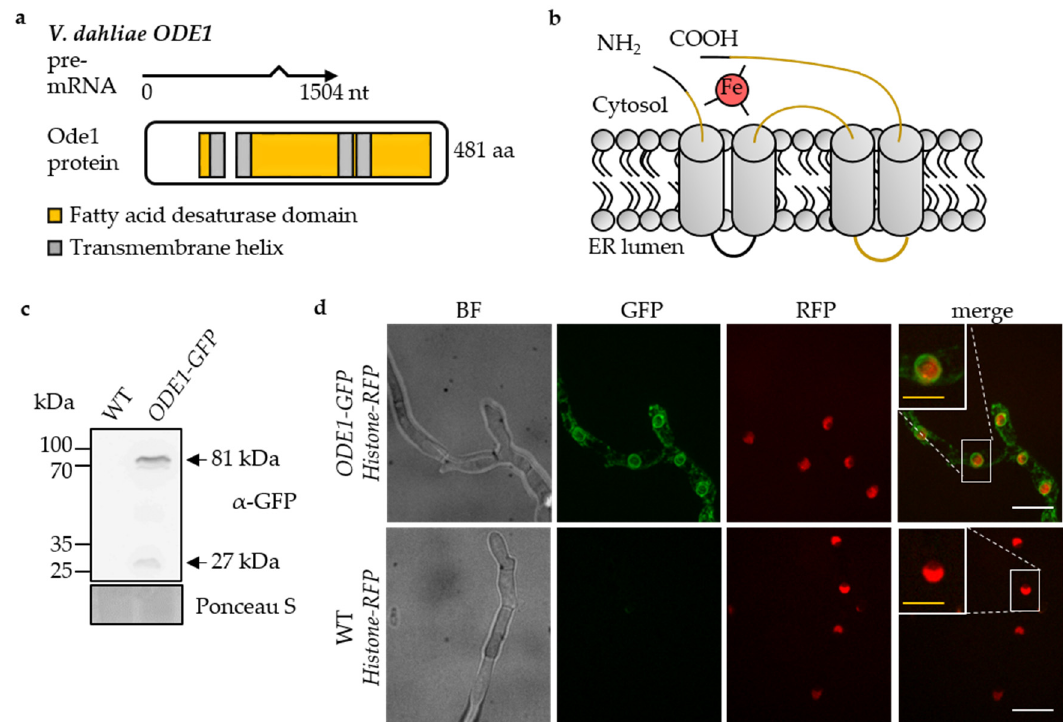
Figure 4. Verticillium dahliae Ode1 is localized to nuclear membranes. The ODE1-GFP strain harbors a functional fusion at the endogenous locus controlled by the native promoter. This strain with or without RFP-tagged histone H2b, and wildtype constitutively expressing RFP-tagged histone H2b (WT Histone-RFP ) were compared. ( a ) V. dahliae oleate ∆ 12-fatty acid desaturase encoding ODE1 intron-exon boundaries (1504 bp) were confirmed by PCR amplification from wildtype cDNA and sequencing. The deduced Ode1 protein (481 aa) contains two fatty acid desaturase domains (FAD; yellow; 77–112 aa, IPR021863; 138–424 aa; IPR005804) and four putative transmembrane helices (grey: 105–124 aa, 136–157 aa, 300–319 aa, 331–350 aa; Phobius). ( b ) Scheme of the predicted Ode1 protein structure. Ode1 is a transmembrane protein. N- and C-termini of Ode1 are directed to the cytosol. The catalytic center is formed by an iron atom (Fe) and the FAD domains (yellow). ( c ) Detection of Ode1-GFP (81 kDa) in immunoblot analysis using GFP-specific antibody. Pon- ceau S staining served as loading control. ( d ) Ode1-GFP is localized to membranes surrounding red nuclei in the ODE1-GFP Histone-RFP strain. Fluorescence microscopy 16 h post inoculation (yellow scale bar = 20 µm, white scale bar = 10 µm).